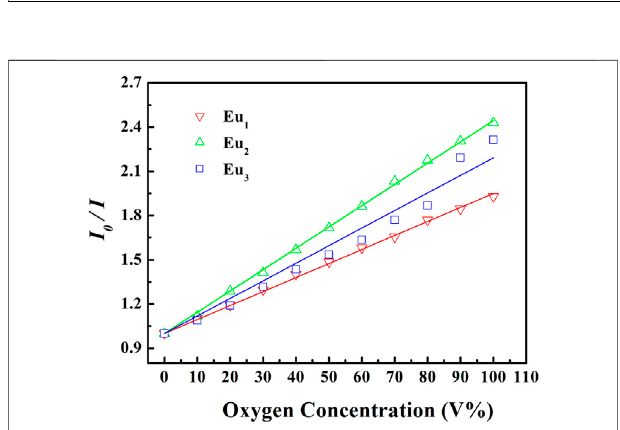
FIGURE 11 | Intensity-based Stern-Volmer plots of Eu 1 , Eu 2 , and Eu 3 at different oxygen concentrations.